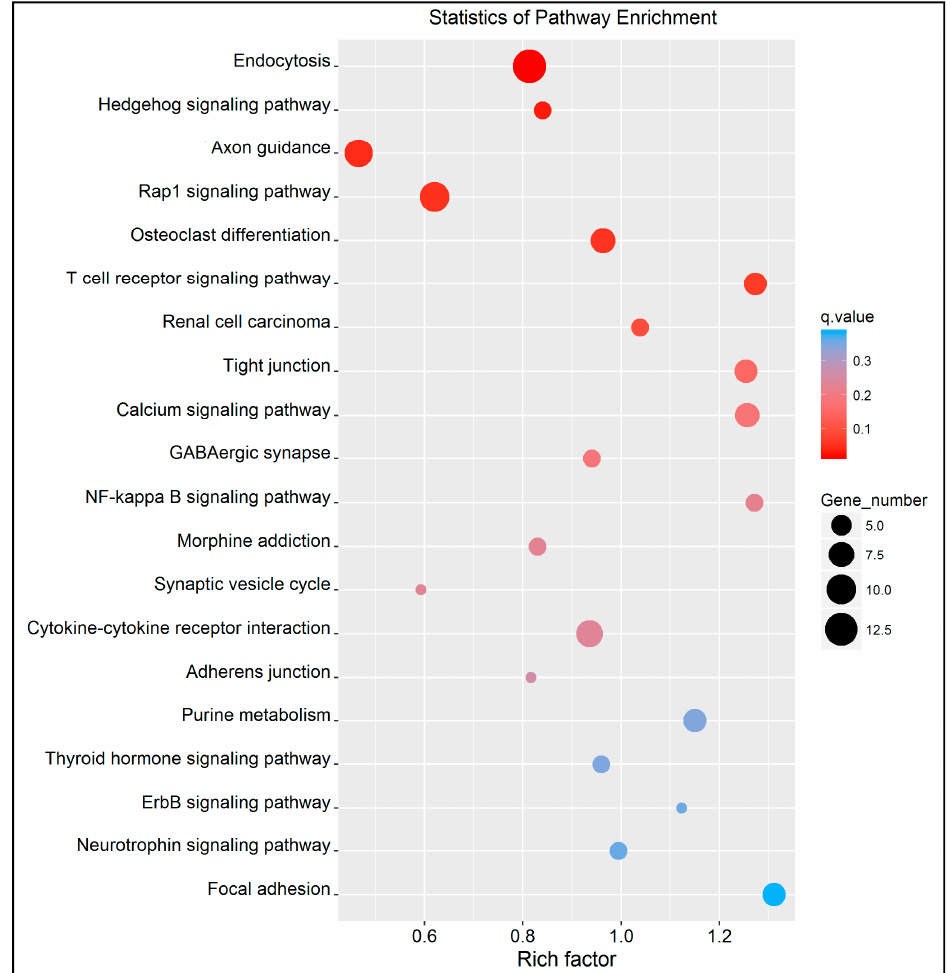
Figure 7. Scatter plot of KEGG pathway enrichment statistics. Top 20 statistics of pathways, enrichment in the KEGG cattle database. The y -axis represents the name of pathway and the x -axis represents the rich factor, the proportion of differentially methylated genes to all the genes that are annotated in a specific pathway term. Dot size represents the number of genes and the color indicates the q value. Table 4. SixDMGsthatoverlappedwithdifferentiallyexpressedgenes(DEGs)( q value < 0.05inbothanalyses). Gene